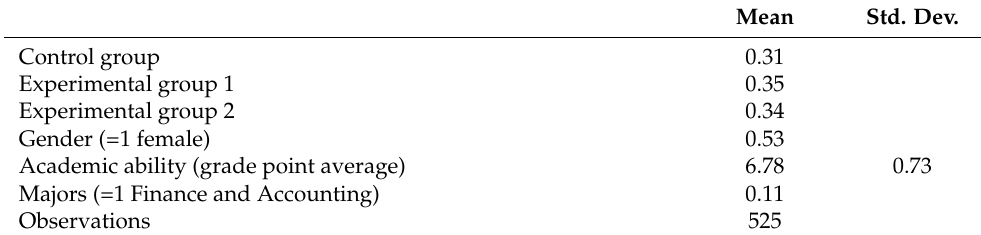
Table A1. Descriptive statistics of the independent variable and covariates.